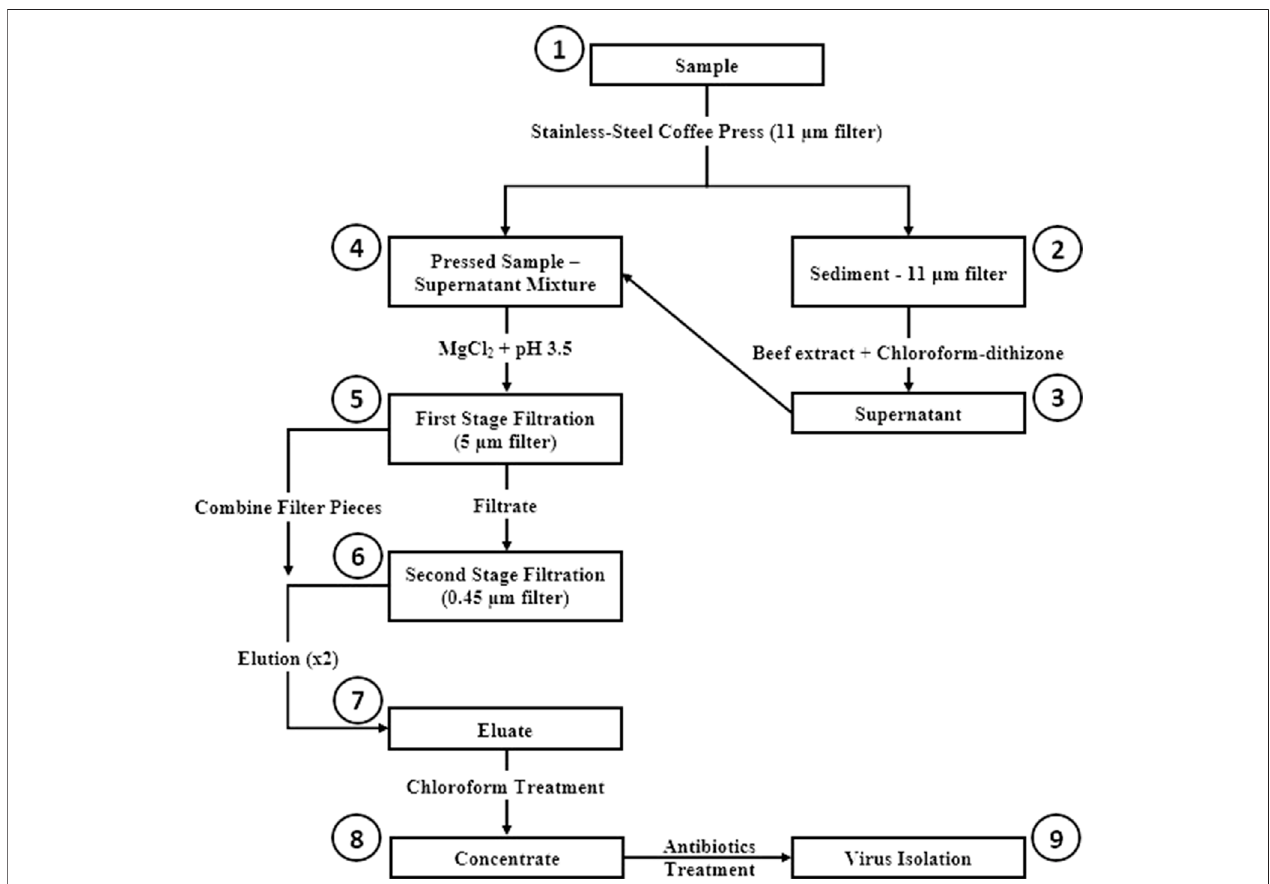
FIGURE 3 | Concentration and Elution Filtration (CaFÉ) method work fl ow chart. 1) Sample is pressed using coffee press with 11 µm fi lter. 2) Viral particles are extracted from Sediment — 11 µm fi lter with beef extract and chloroforrn-dithizone. 3) Supernatant is added to the main pressed sample. 4) MgCl 2 is added to the pressed sample-supernatant mixture and pH is adjusted to 3.5. 5) Sample is fi ltered using 5 µm fi lter. 6) Filtrate is then, fi ltered again with 0.45 µm fi lter and fi lter pieces from the two fi ltration stages are combined and eluted with beef extract. 7) The resulted eluate is chloroform treated. 8) Concentrate is inoculated into RD and L20B cell lines after antibiotics treatment. 9) Inoculated samples are observed for 5 days post- inoculation, following WHO ENVS Virus Isolation Algorithm.